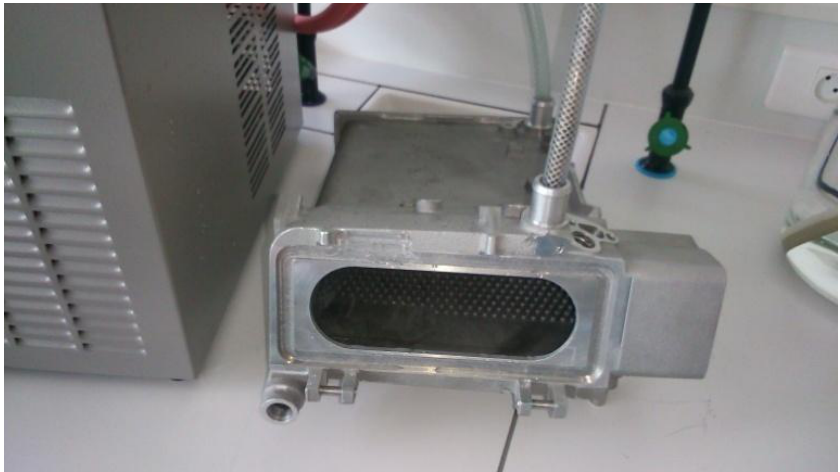
Figure 3. Boiler condenser used for the water recovery experiments .